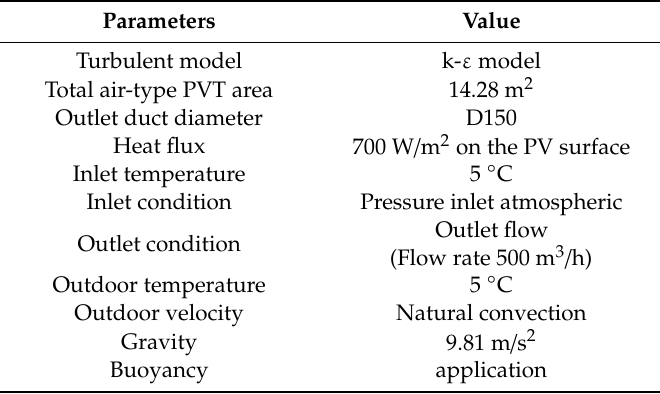
Figure 7. The computational domain of the air-type BIPVT collector connection. Table 2. Computational fluid dynamics (CFD) simulation conditions.